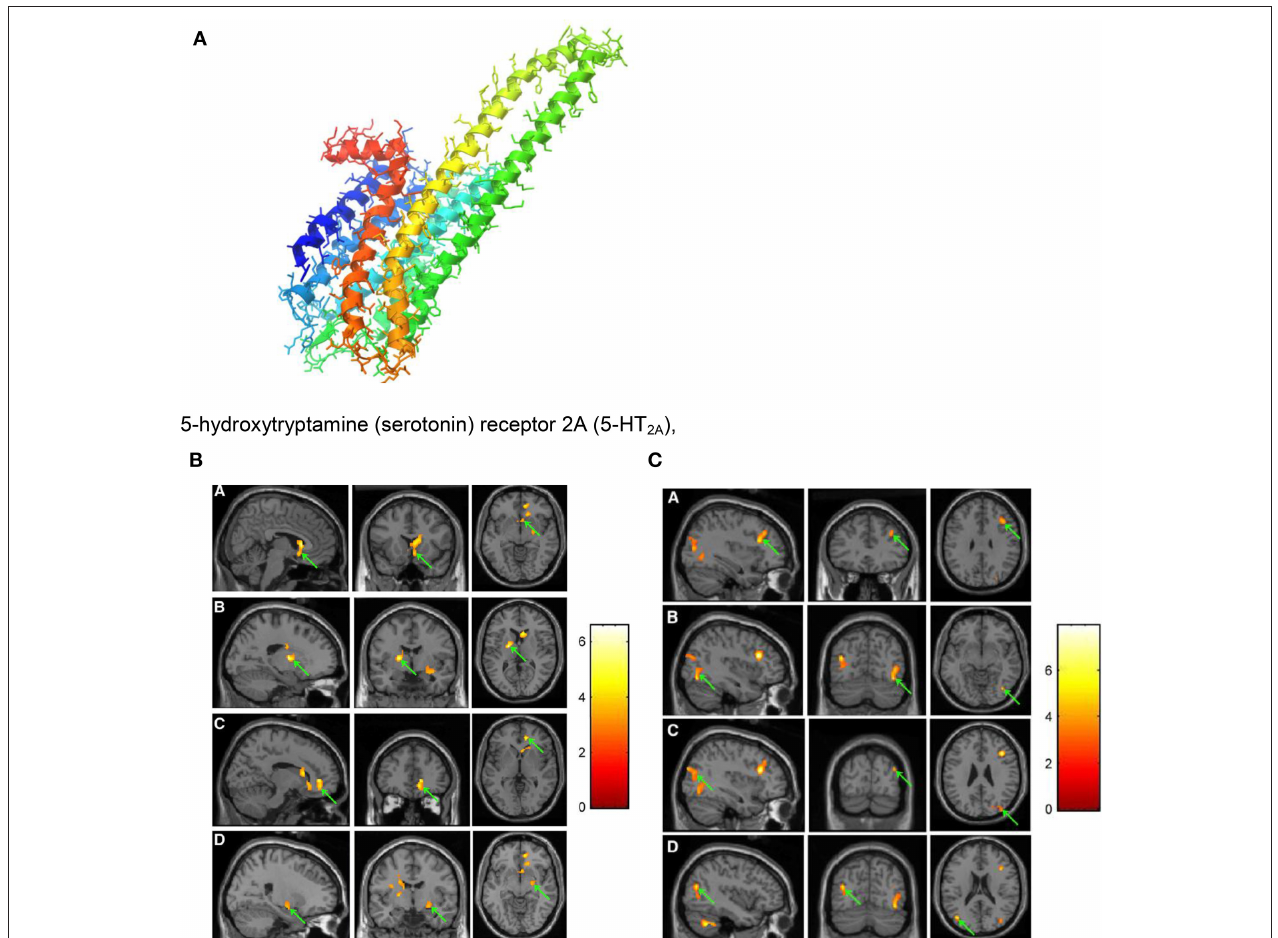
FIGURE 9 | (A) 5-hydroxytryptamine (serotonin) receptor 2A (5-HT 2A ), G protein coupled; diameter of the protein alpha-helix ∼ 0.5nm https://en.wikipedia.org/wiki/5- HT2A_receptor downloaded 4. 10. 2016. (B) PET images showing decrease in 11 C-NMSP binding clusters (arrows) in a subject listening to frightening music: right caudate head, right frontal subgirus, and right anterior cingulated (A); left lateral globus pallidus and left caudate body (B); right anterior cingulated (C); and right superior temporal gyrus, right claustrum, and right amygdala. (D) (Zhang et al., 2012). Reprinted with permission from Zhang et al. (2012) © 2012 SNMMI. (C) PET images showing increase in 11C-NMSP binding clusters (arrows) in a subject listening to frightening music: right frontal lobe and middle frontal gyrus (A); right fusiform gyrus and right middle occipital gyrus (B); right superior occipital gyrus, right middle occipital gyrus (C); and left middle temporal gyrus (D) ( Zhang et al., 2012). Reprinted with permission from Zhang et al. (2012) © 2012 SNMMI.